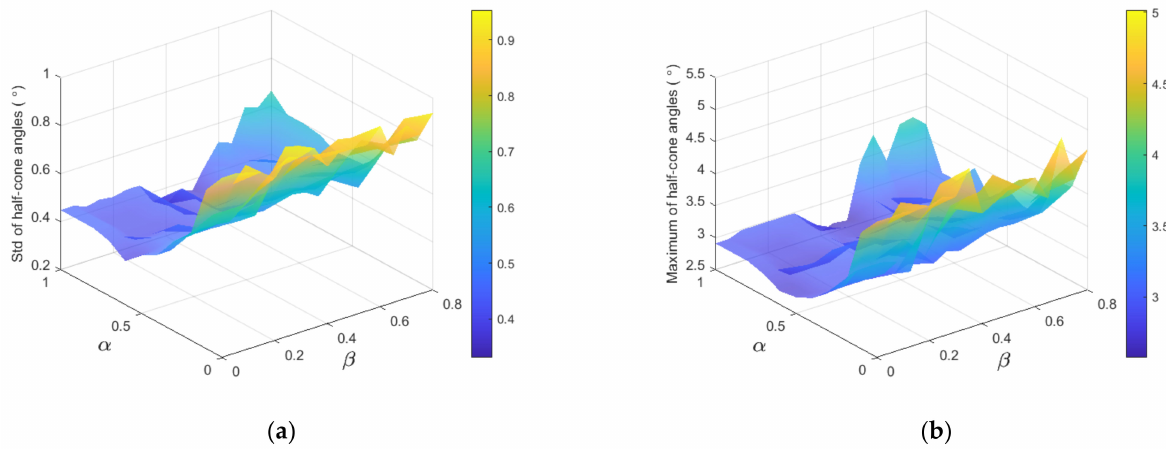
Figure 13. Characteristics of the beam widths: ( a ) Standard deviation of half-cone angles in terms of α and β ; ( b ) Maximum of half-cone angles in terms of α and β